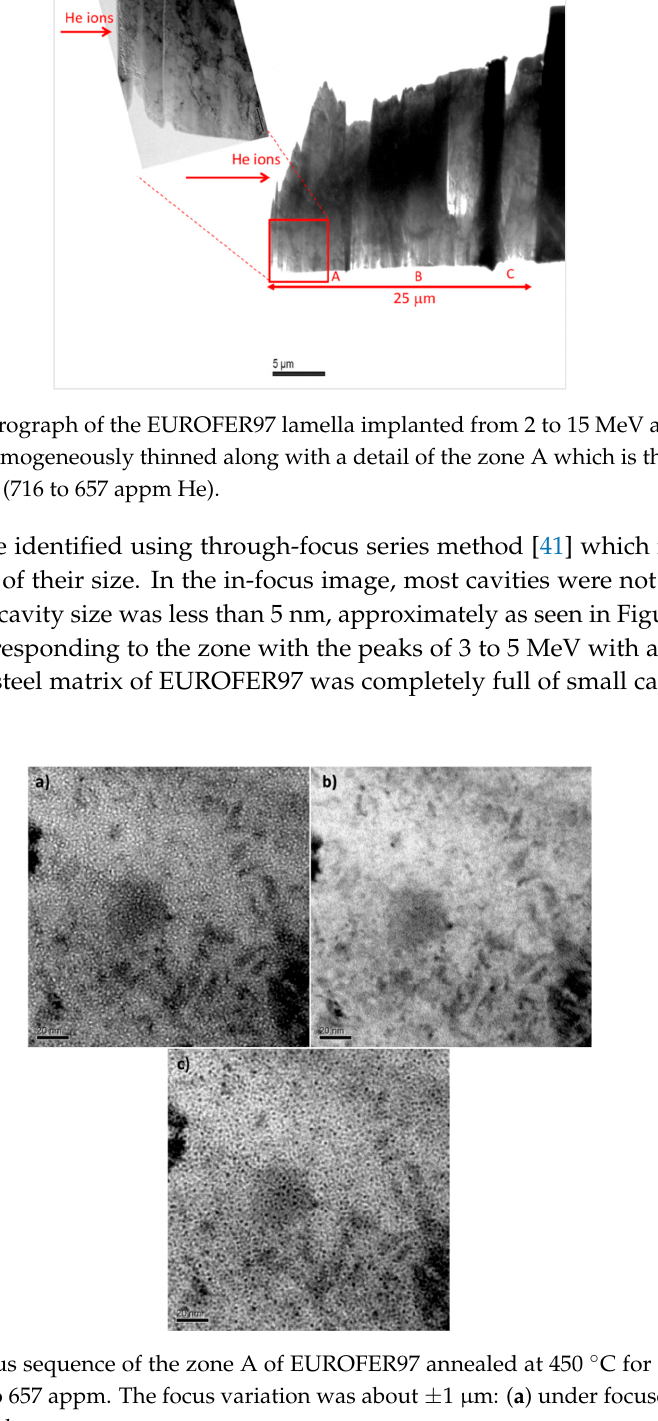
Figure 5. TEM focus sequence of the zone A of EUROFER97 annealed at 450 °C for 100 h and a He content from 716 to 657 appm. The focus variation was about ±1 µm: ( a ) under focused, ( b ) in-focus, and ( c ) over focused.